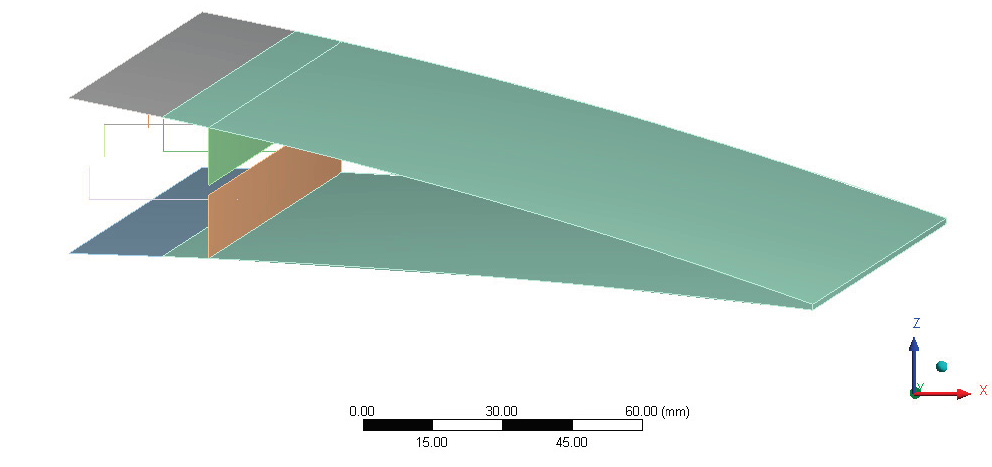
Figure 10. The geometric model of open cell design for finite element